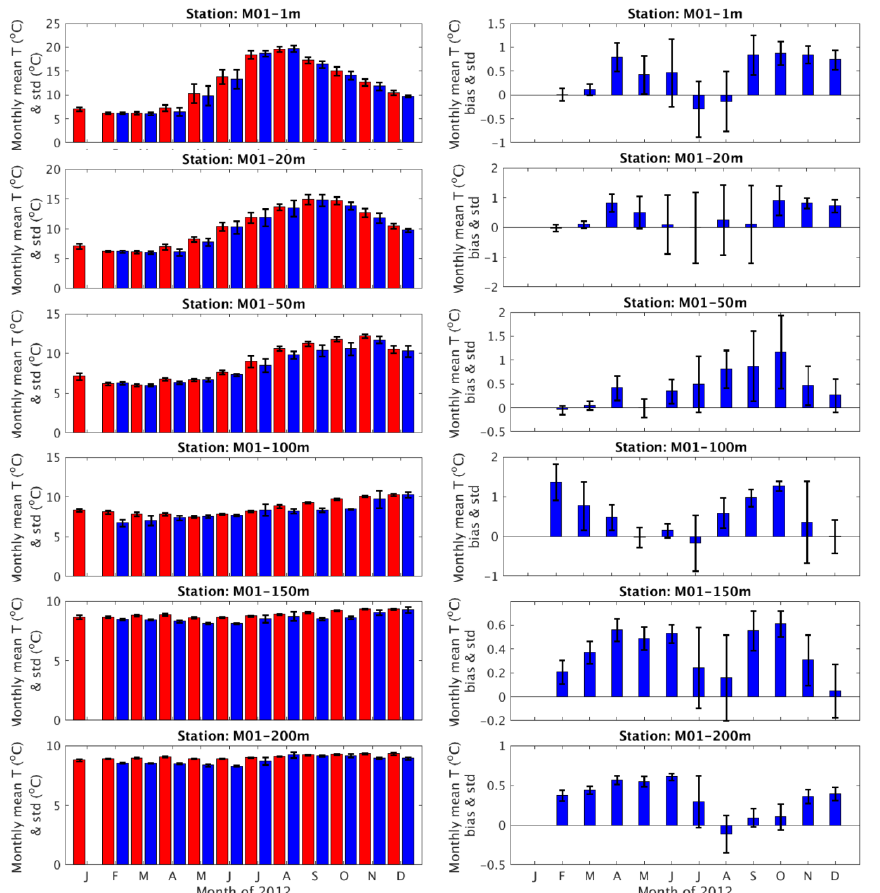
Figure 6. ( Left panel ) Comparison of the monthly averaged water temperature between the model (red bars) and the observations (blue bars) at the NeraCOOS buoy M01. The measurement depths are as shown on each plot. On some plots the observations do not appear due to the lack of data. ( Right panel ) Bias of the modeled monthly mean temperature. The thin lines on top of each bar plot represent the corresponding standard deviations.